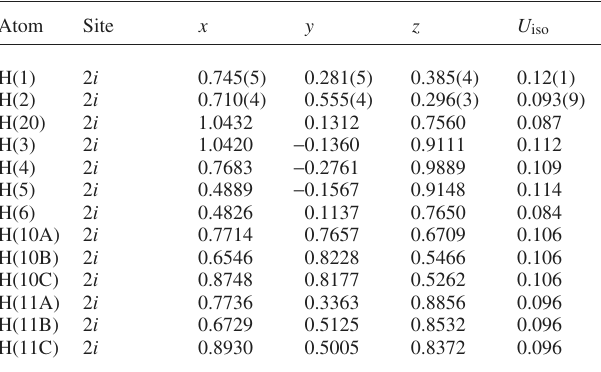
Table 2. Atomic coordinates and displacement parameters (in Å 2 ) . Table 1. Data collection and